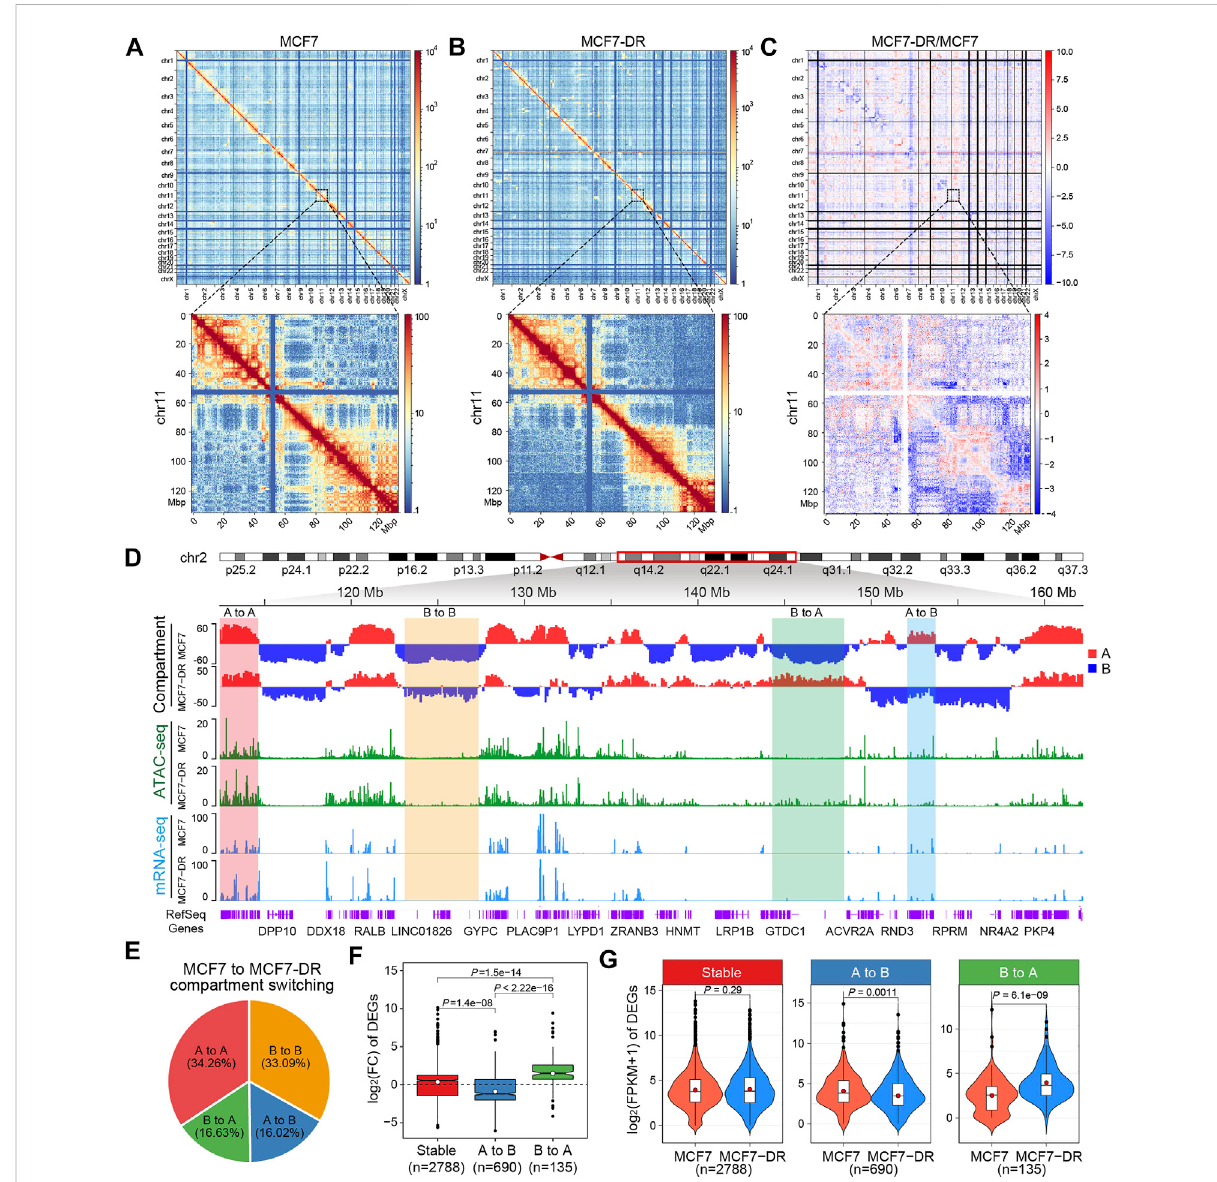
FIGURE 1 Compartment switching is associated with differential gene transcription. (A,B) Genome-wide all-by-all Hi-C interaction heatmaps at 1-Mb resolution in MCF7 (A) and MCF7-DR (B) cells. The chromosomes are stacked in numerical order from left to right and top to bottom. The color bar depicts the frequency of Hi-C interactions. The lower panels are enlargements of the chr11 at 200-kb resolution in the upper panels. (C) Genome- wide heatmap showing the log2 ratio comparisons of Hi-C interaction frequencies at 1-Mb resolution in MCF7-DR cells compared to parental MCF7 cells. The log2 ratio values are shown according to the color scale. The lower panel represents the enlargement of the chr11 at 200-kb resolution in the upper panel. (D) A representative image from the Integrated Genome Browser (IGV) that shows the open A-type (red) and closed B-type (blue) compartmentalization of chr2 at 100-kb resolution. Examples of regions with either stable or differential compartmentalization are shadedindifferentcolors.TracksshowingATAC-seqandRNA-seqreadcoverageareindicatedbygreenandbluebars,respectively. (E) Thegenomic compartment changes at 100-kb resolution between MCF7 and MCF7-DR genomes. “ A ” and “ B ” represent the open and closed compartments, respectively. “ Ato A ” denotes compartmentsthat areopen inbothcell lines, “ BtoB ” representscompartmentsthat are closedin bothcell lines, “ A to B ” denotes compartments that are open in MCF7 but closed in MCF7-DR, and “ B to A ” denotes compartments that are closed in MCF7 and open in MCF7-DR. (F) Box plot showing MCF7-DR/MCF7 log2 fold change (FC) of DEGs residing at regions for different compartmental switch categories (100-kbresolution).Statisticalsigni fi cancewasdeterminedbytheWilcoxonrank-sumtest.Theblackhorizontaldottedlinerepresentsthelog 2 (FC)= 0. In each box plot, the median and mean values are indicated by the horizontal black line and the white dot, respectively. The number of DEGs associated with compartment switching was marked below each box. (G) Violin plots showing expression level [log 2 (FPKM+1)] of DEGs residing at regions for different compartmental switch categories. The horizontal black line within each white box indicates the median value while the red dot represents themean value. ForcomparisonsbetweenMCF7 andMCF7-DRcell lines, statisticalsigni fi cance was calculated using theWilcoxon rank- sum test.